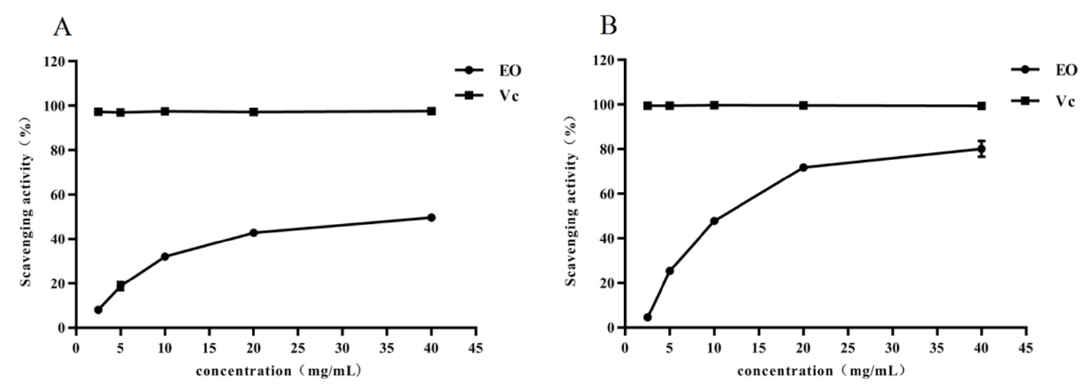
Figure 1. Antioxidant abilities of EEO leaves essential oils, ( A ) DPPH radical scavenging ability and ( B )ABTS radical scavenging ability.